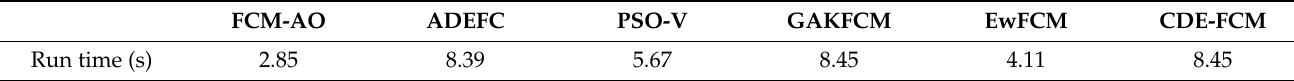
Table 3. Runtime of algorithms for Data1 .